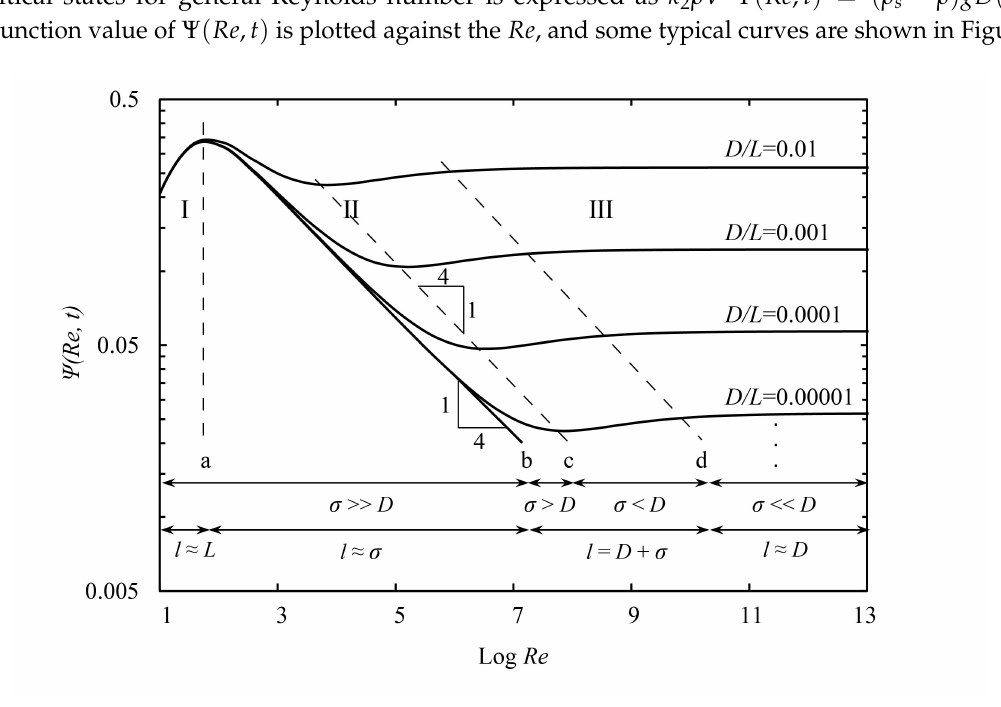
Figure 5. The function value, Ψ ( Re , t ) , plotted against Re for four typical relative roughness: D / L = 0.01; D / L = 0.001; D / L = 0.0001; D / L =